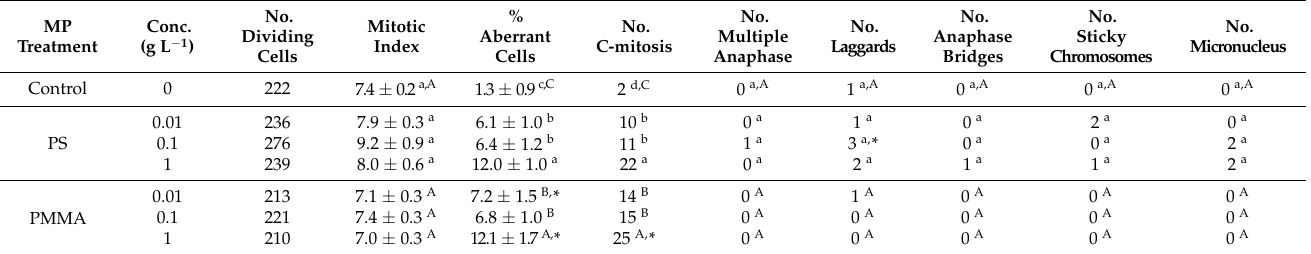
Table 2. Mitotic index and chromosome aberrations in control A. cepa root meristem cells and after 72 h treatment with 0.01, 0.1, and 1 g L − 1 of PS-MPs and